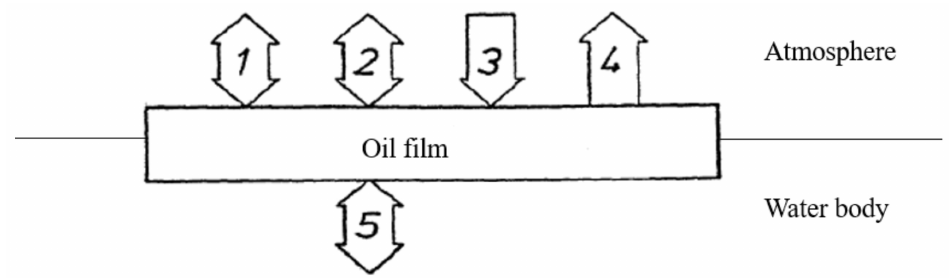
Figure 2. Schematic diagram of the heat balance of an oil film. 1 = heat transfer between the atmosphere and the oil film; 2 = heat radiation between atmosphere and oil film; 3 = solar radiation; 4 = evaporative heat loss; 5 = heat transfer between oil film and